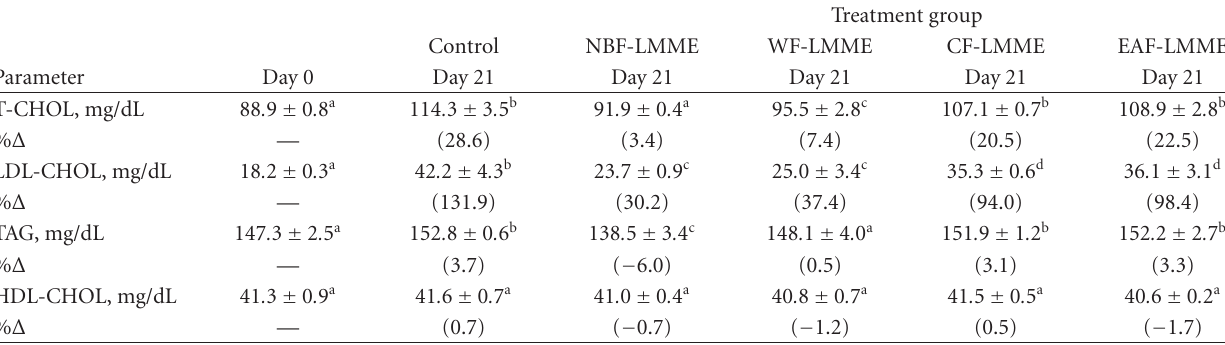
Table 1: Changes in serum lipid levels in mice orally administered with the various fractions recovered from Loranthus micranthus methanolic leaf extract for 21 days.